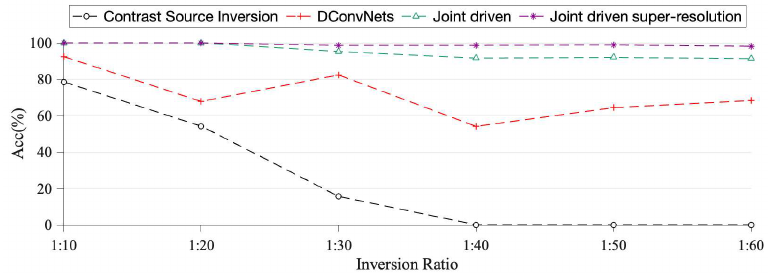
Figure 11. Accuracy of four inversion algorithms for detection.